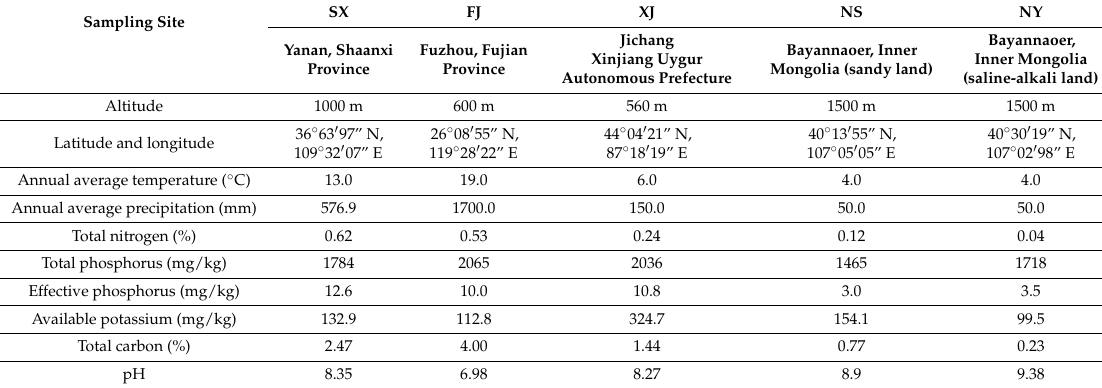
Table 1. Geographical sources and physicochemical properties of soil